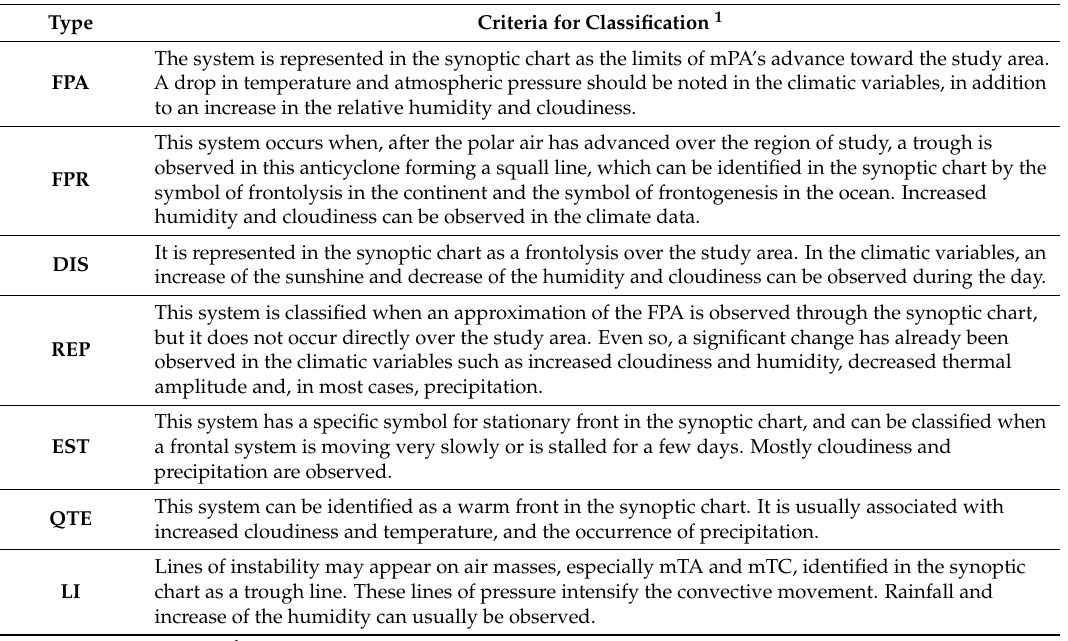
1 Source: Table generated according to data provided by